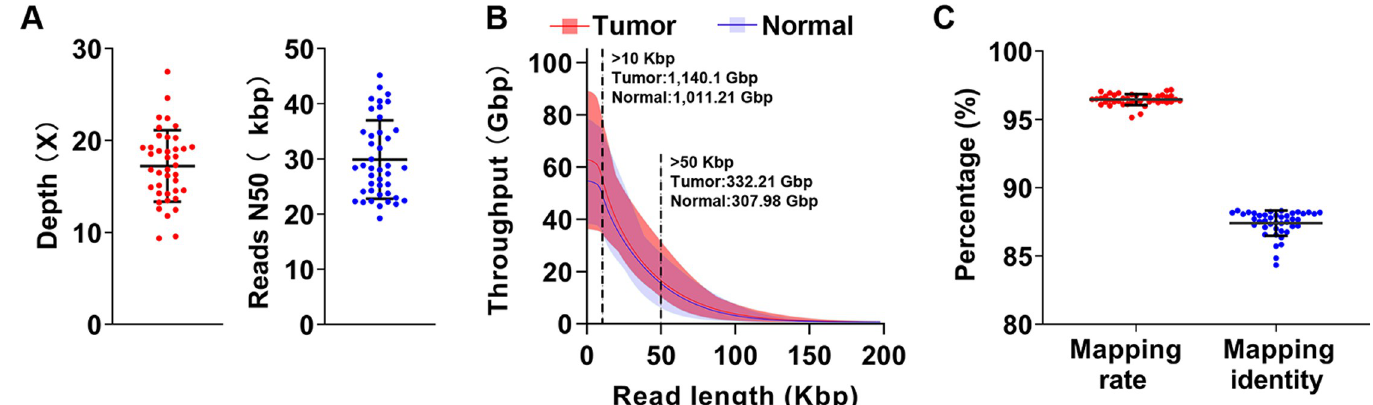
Fig 1. Summary of the long-read sequencing data. (A) The sequencing depth (left) and reads N50 (right) of long-read data obtained from 21 pairs of tumor/ normal samples via nanopore sequencer. (B) Cumulative distribution of total bases (Y axis) over read length (X axis) for tumor/ normal samples. The quantities of bases in reads 10 Kbp+ and 50 Kbp+ were labeled. (C) The mapping rate and identity of long-reads sequencing.